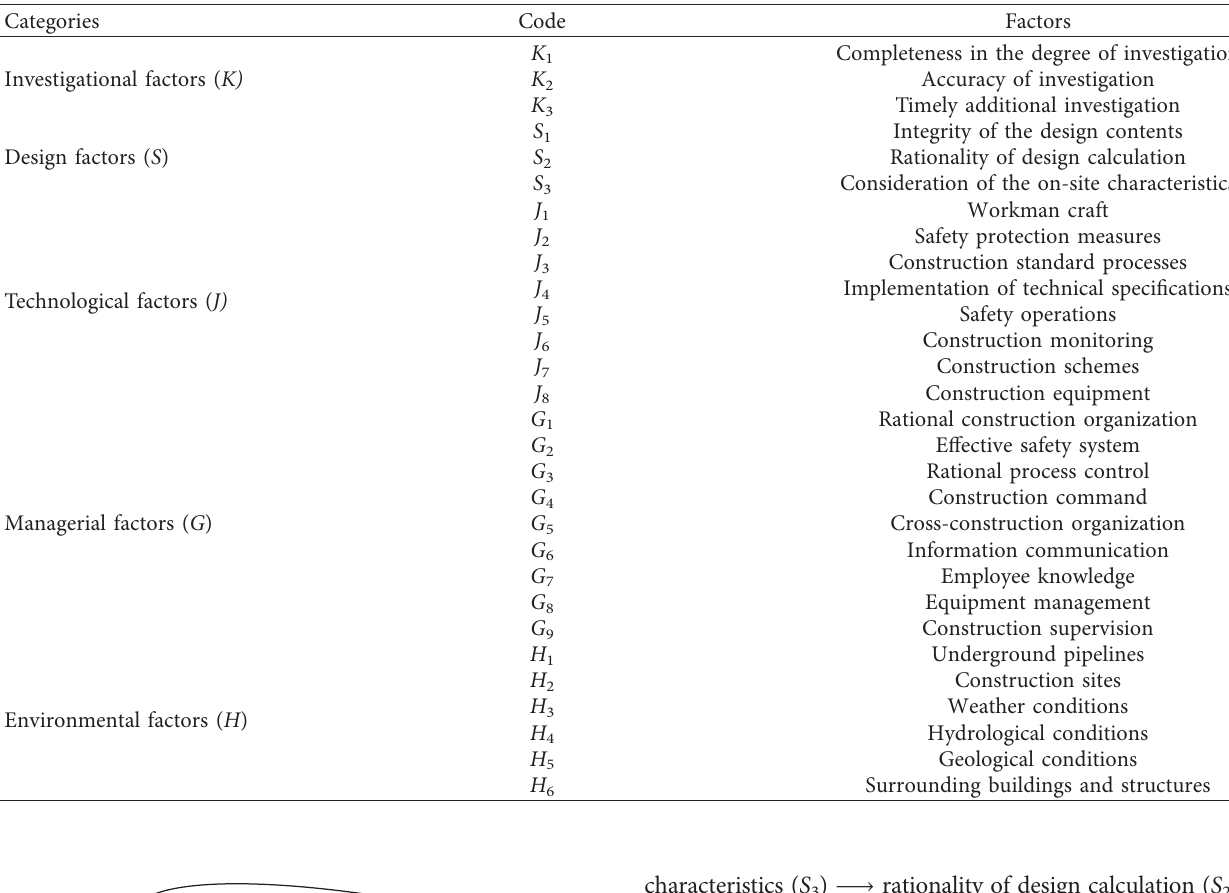
characteristics ( S ) ⟶ rationality of design calculation ( S ), 3 2 and integrity of the design ( S )). A similar analysis was 1 performed for the other three categories. Causal relationships among the 5 categories and 29 factors are displayed in Figure 4. 4.4. Causal Loop Diagram. Figure 3 depicts the causal loop diagram of risk factor categories, and Figure 4 details the causal loop diagram considering all the risk factors. For instance, design risks are directly influenced by investigation risks. On the other hand, investigational risks are affected by environmental risks. Only positive (+) impacts (magnifi- cation effect of interaction) were considered, meaning that the risks were reinforced and diminished corresponding to